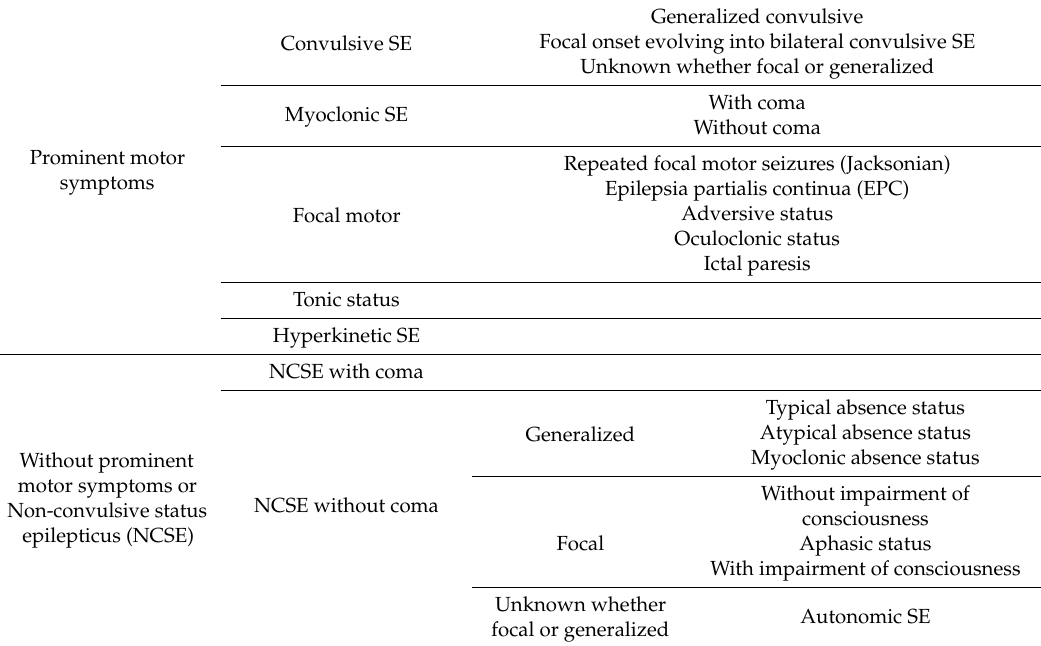
Table 3. Semeiologic classification of Status Epilepticus (SE).